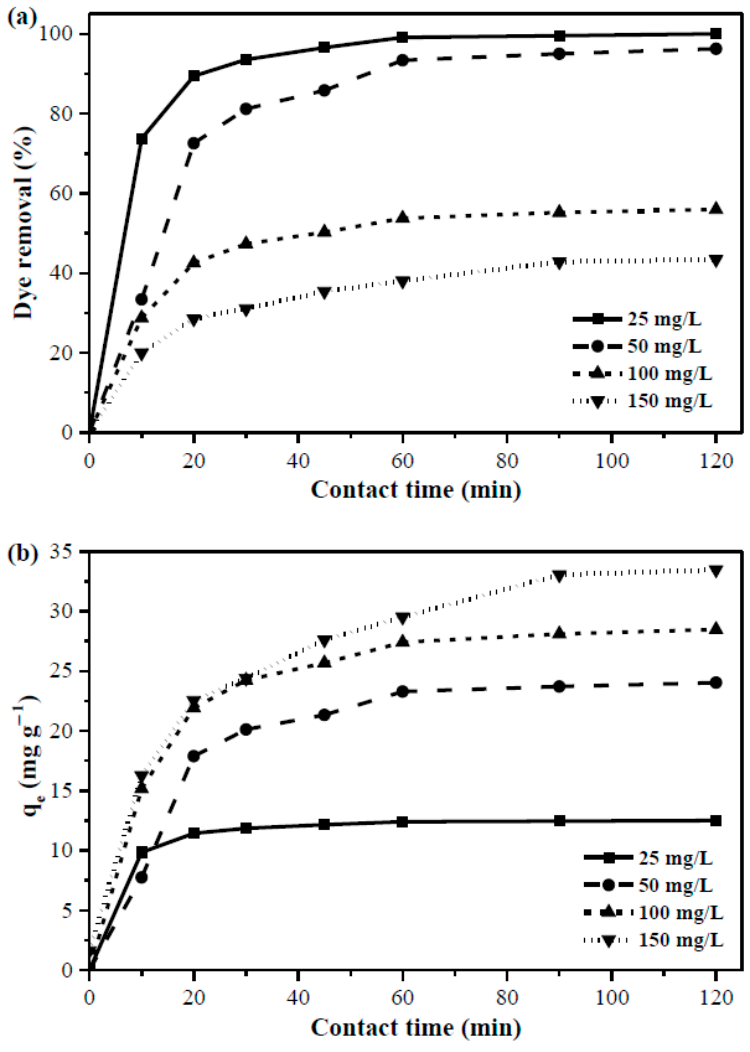
Figure 6 Figure 6. ( a ) The percent removal of dyes and ( b ) amount of dyes adsorbed for variable contact time and initial concentration (pH: 7, C i : 25, 50, 100, and 150 mg/L, M ads : 0.5 g, t : 0 to 120 min, T: 25 ◦ C, S: 180 rpm, solution volume: 250